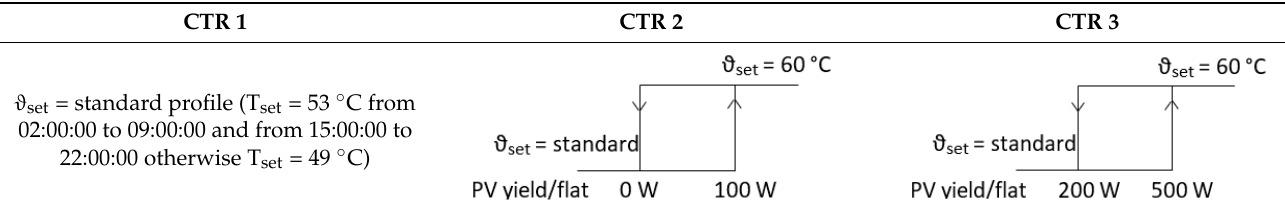
Table 5. Control logics of the set point of the decentral storage depending on the PV yield. CTR 1 CTR 2 CTR 3